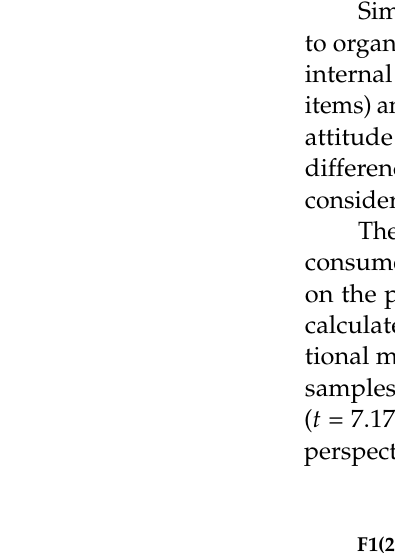
Table 6. Coefficient estimates and diagnostics from hierarchical binary logistic regression explain- ing consumers’ revisit behaviour (study 2; 𝑛 = 301). Model 1: Consumer Profiling Variables